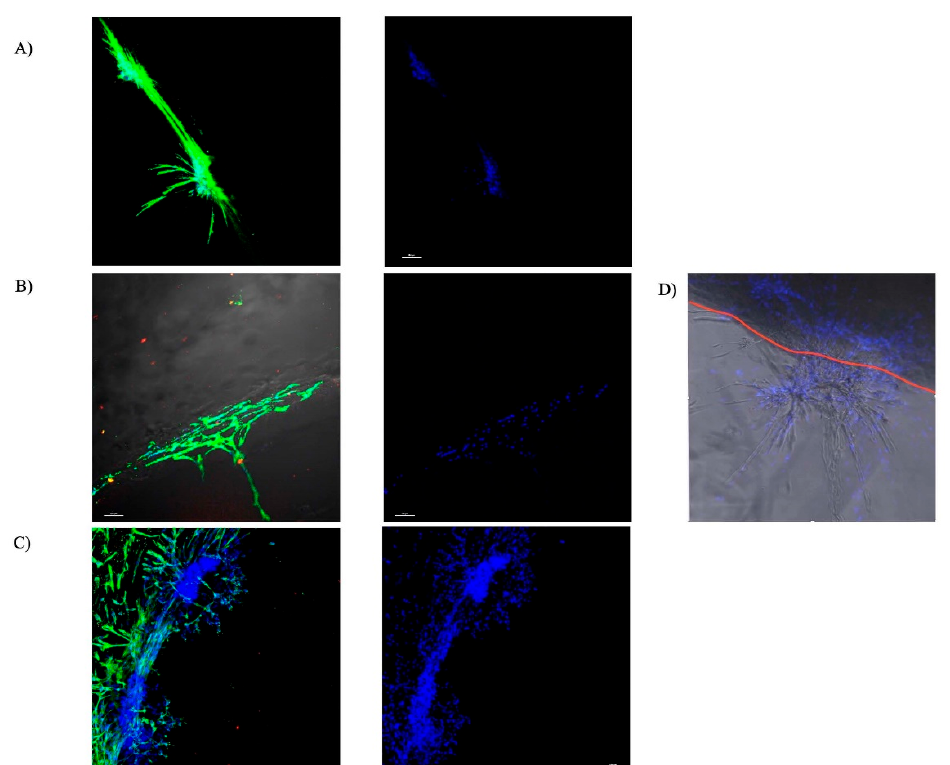
Figure 2. Representative images of the ring/core interface with rat MSCs expressing α -SMA migrating into the core Gtn–HPA. DAPI, blue; Anti α -SMA, green (Scale bar 100 µ ). ( A ) Control Gtn–HPA gel. ( B ) Gtn–HPA incorporating PDGF-BB. ( C ) Gtn–HPA incorporating PRP lysate. ( D ) representative image illustrating the superimposed image from the confocal microscopy of one of the samples showing the chain migration and the branching of the chains as the cells migrate into the gel. The red line illustrates the demarcation of the interface between the collagen ring and the core-Gtn–HPA hydrogel.